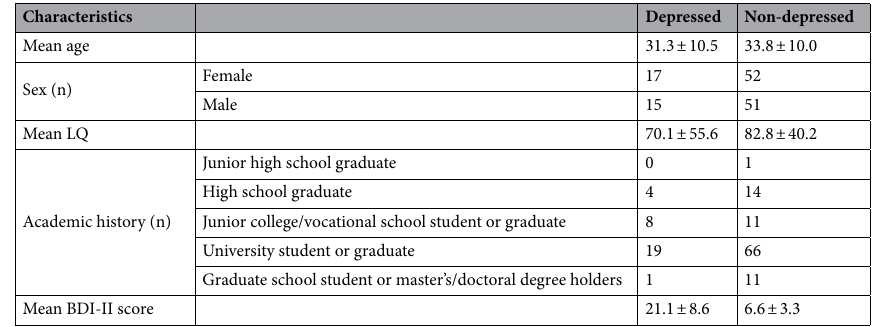
Table 1. Characteristics of the depressed and non-depressed individuals. The values following ± indicate the standard deviations. LQ, laterality quotient; BDI-II, Beck Depression